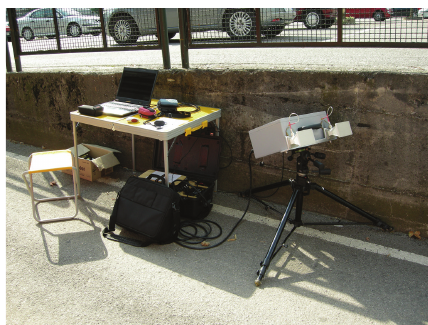
Figure 4: Radar measurement of the lateral span no. 8 in Figure 1.